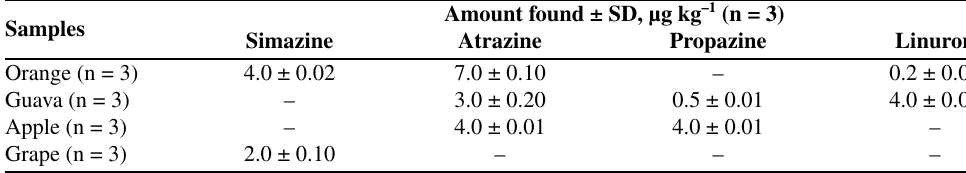
Table 4. Analysis of selected herbicides in fruit juice samples Samples